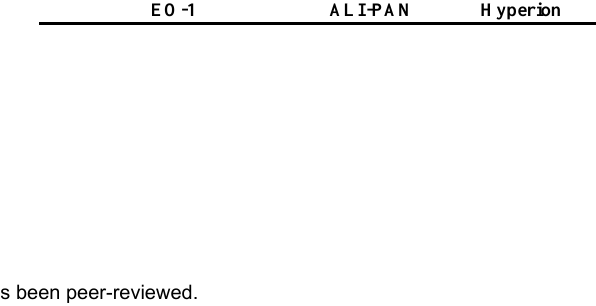
Table 1. The characteristics of the EO-1